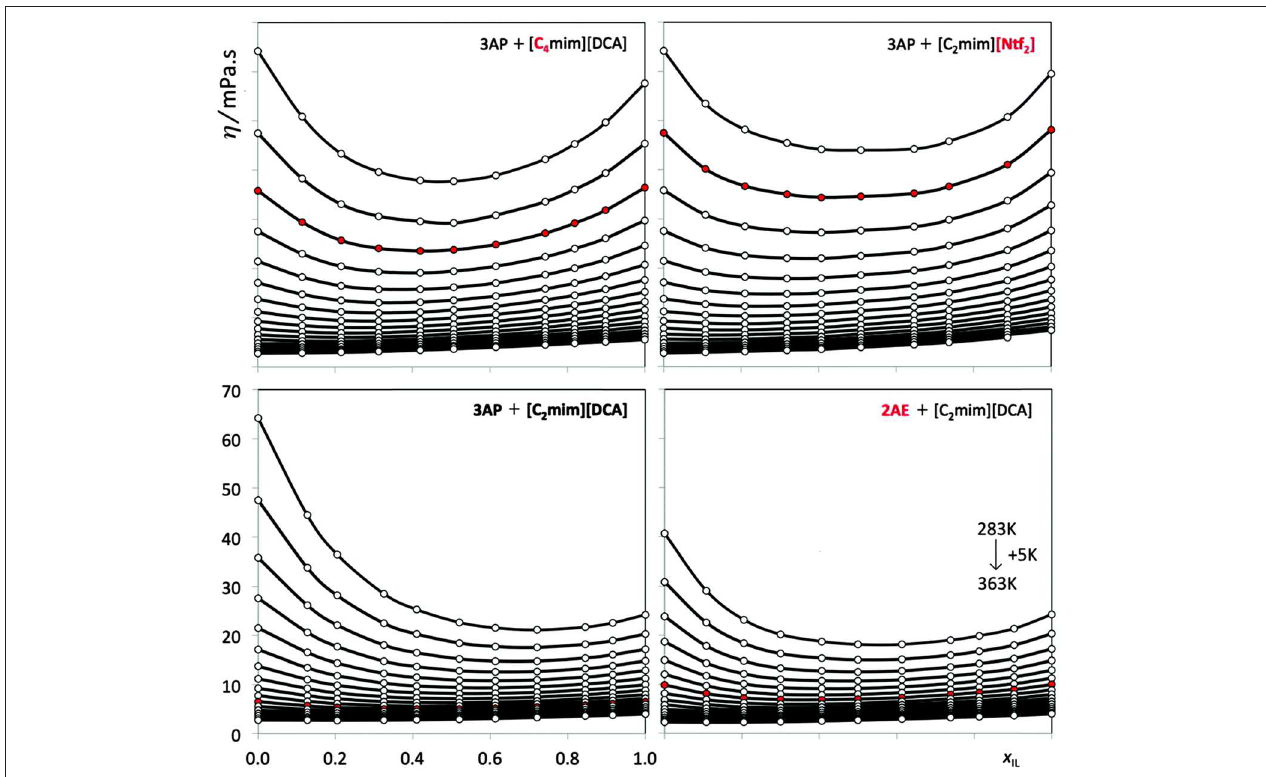
FIGURE 3 | Experimental viscosity data, η /mPa · s, of four (ionic liquid plus molecular solvent) binary mixtures as a function of the ionic liquid mole fraction, x IL . The curves represent different isotherms. The red circles denote for each system the isotherm closest to the viscosity crossover temperature. (Reprinted from Tariq et al., 2015 with permission from Royal Society of